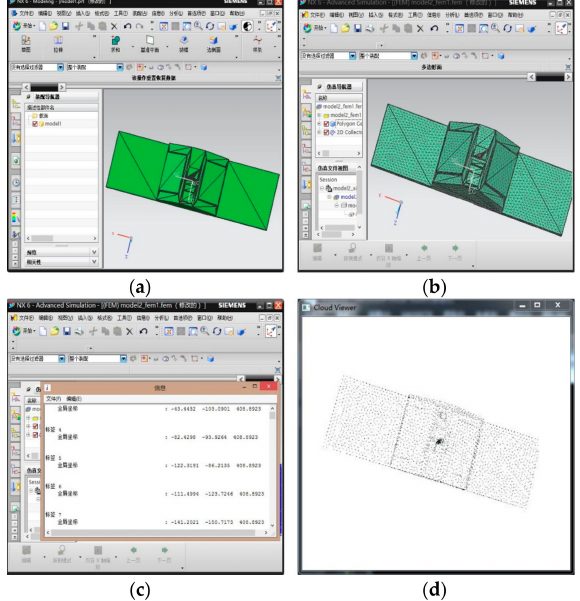
Figure 6. The procedure of generating the model point cloud from the 3D CAD target model ( a ) the CAD model is loaded in the UG software; ( b ) the result of finite element analysis; ( c ) the output of the point coordinate of the triangular mesh; ( d ) the 3D display of the model point